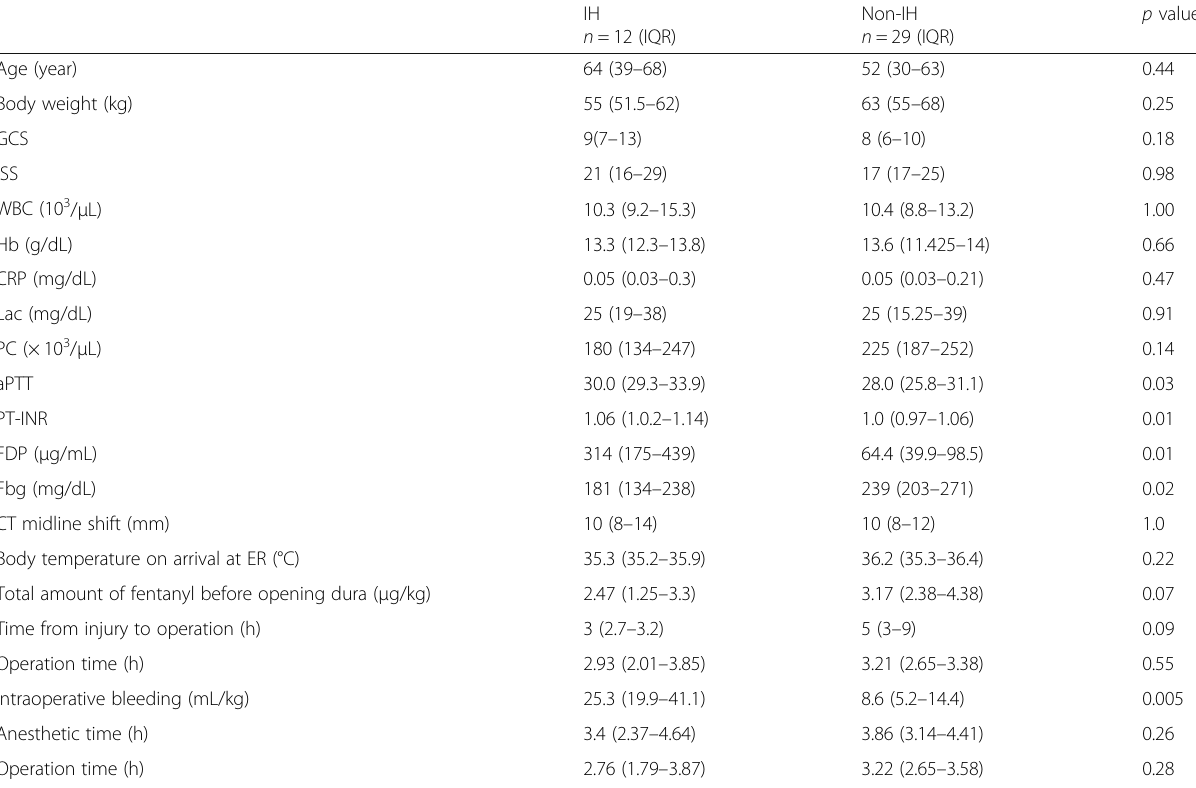
Table 3 Demographic date, laboratory variables, radiographic findings, and operation date of patients with or without IH